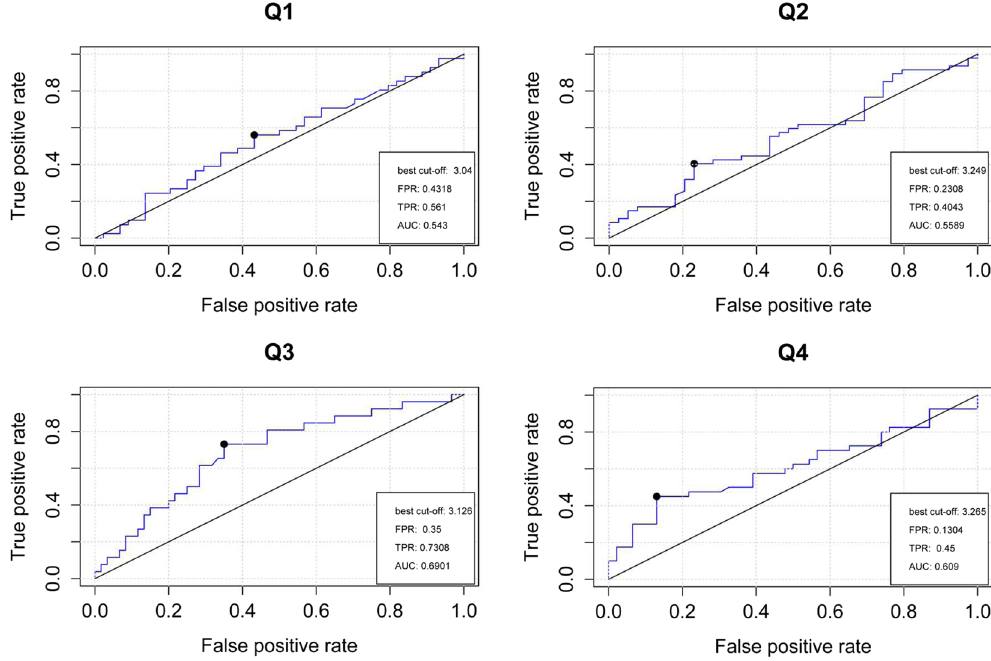
Figure 2. Relative operating characteristic (ROC) curve analyses of osteocalcin in predicting the ED risk in four different groups (Q1 < levels of 25%, 25% ≤ Q2 ≤ 50%, 50% < Q3 ≤ 75%, Q4 > 75%) on the basis of testosterone levels among 40–49 years. The Best cut-off, area under the curve (AUC), False Positive Rate (FPR) and True Positive Rate (TPR) are shown in the